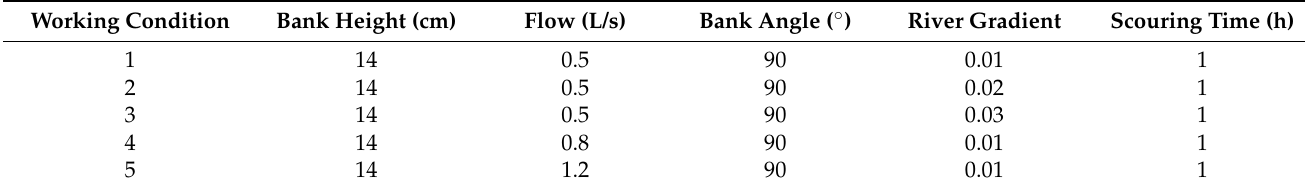
Table 1. The detailed arrangement of experimental groups.